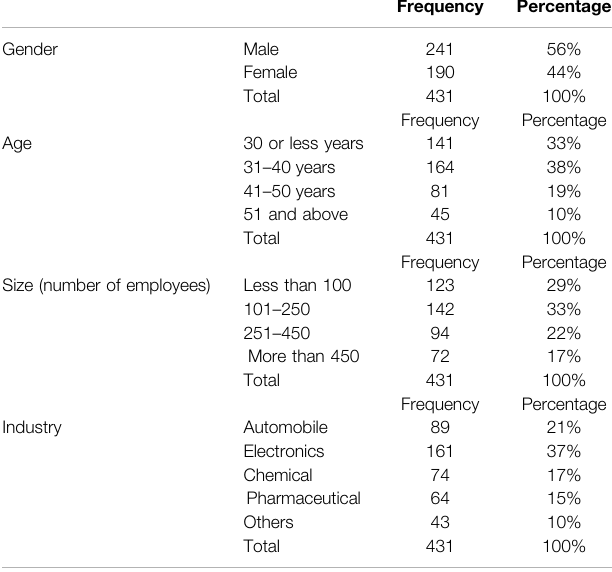
TABLE 2 | Descriptive